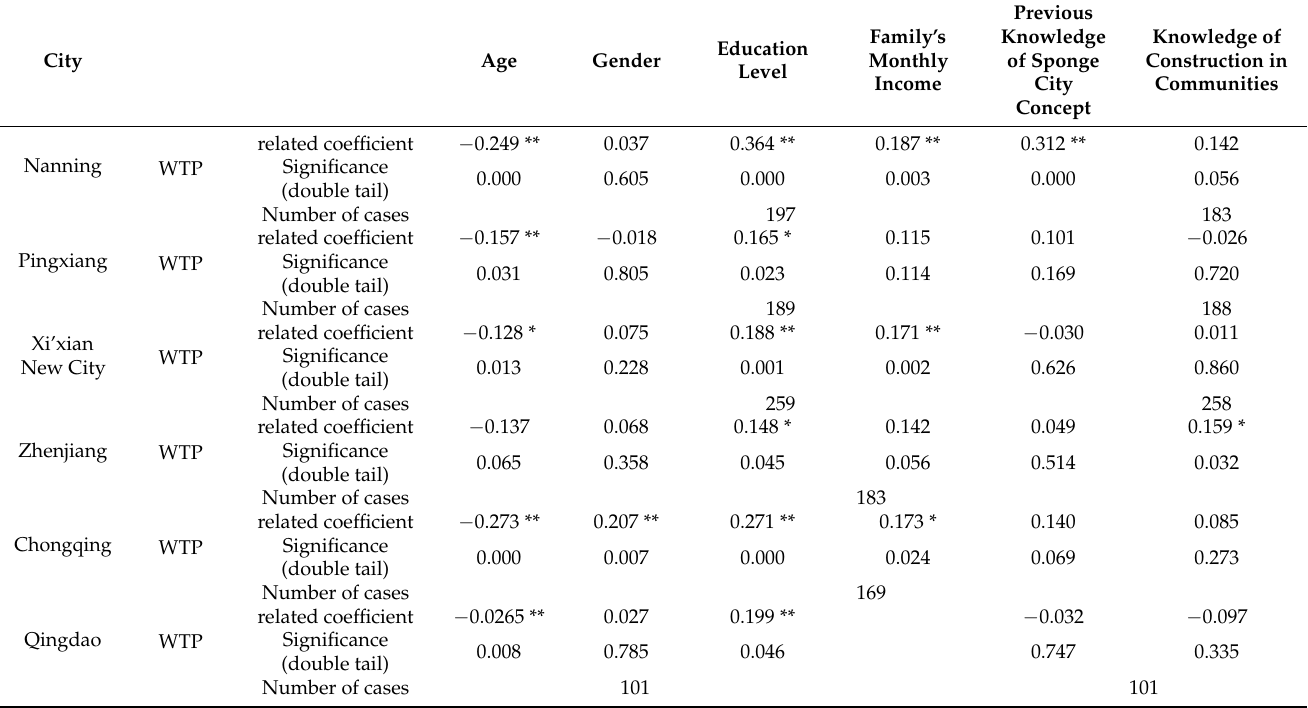
Table 3. Factors influencing respondents’ WTP for urban green infrastructure in six pilot sponge